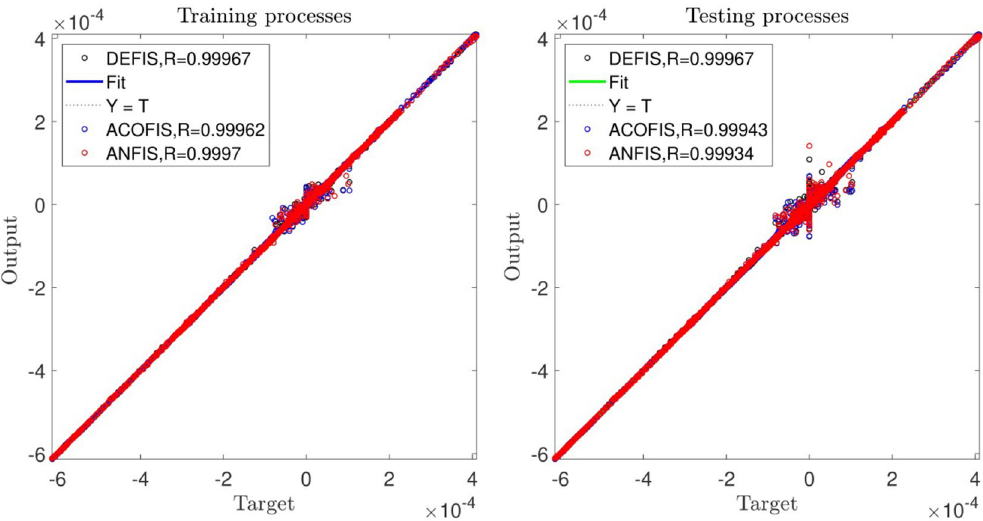
Figure 8. Correlation coefficient of DEFIS, ACOFIS, and ANFIS methods for training and testing processes after achieving the best